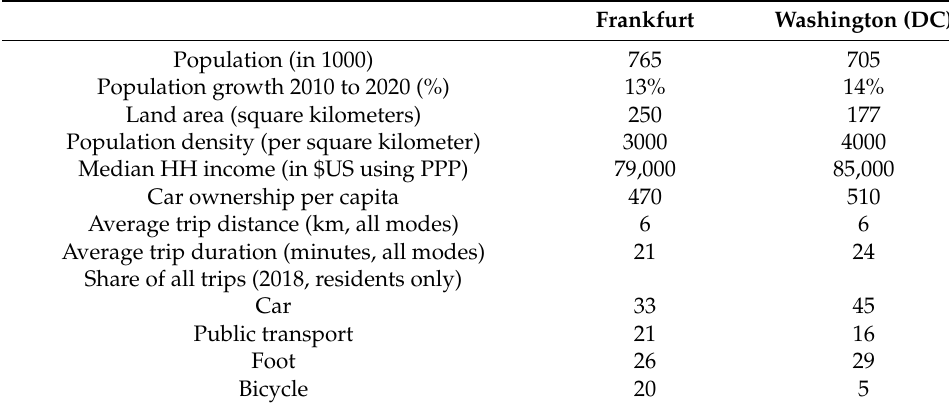
Table 1. Overview of demographics, geography, and transport indicators for Frankfurt and Washing-